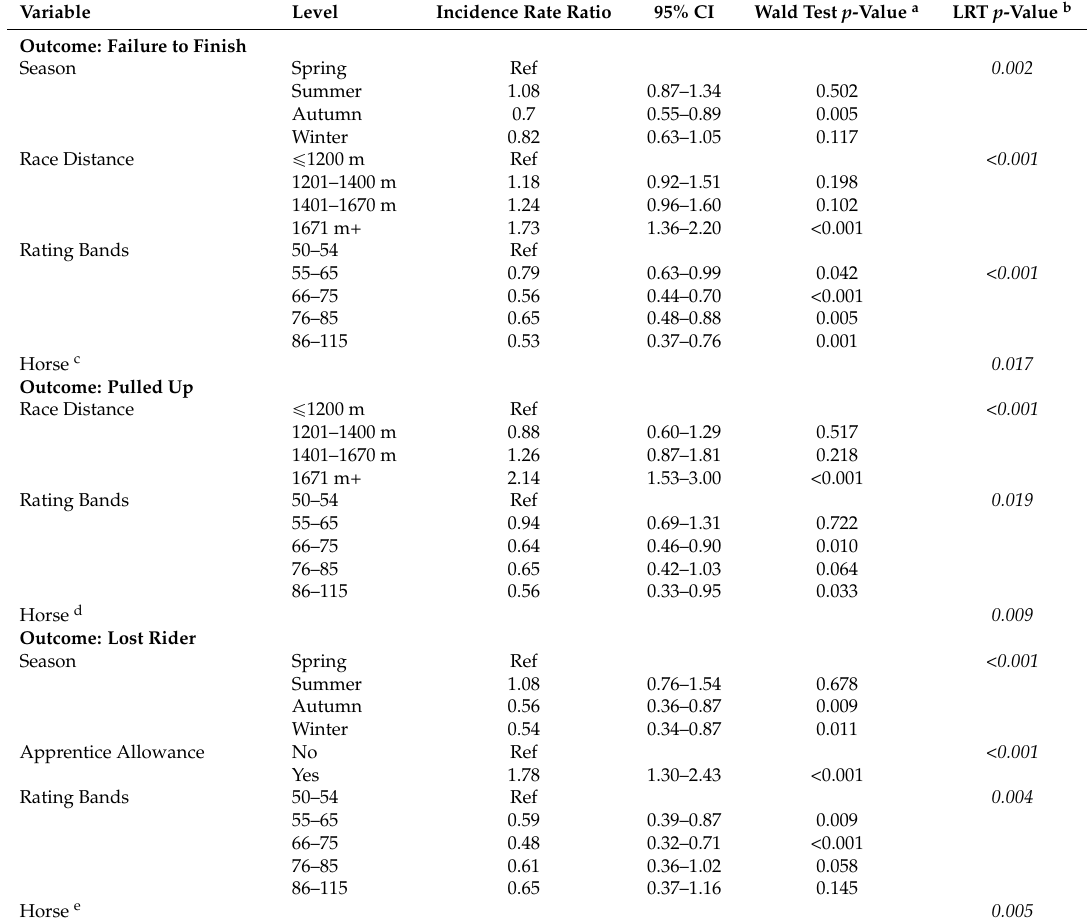
a Wald Test p -value reported as a test for linear trend for continuous variables and ordered categories;